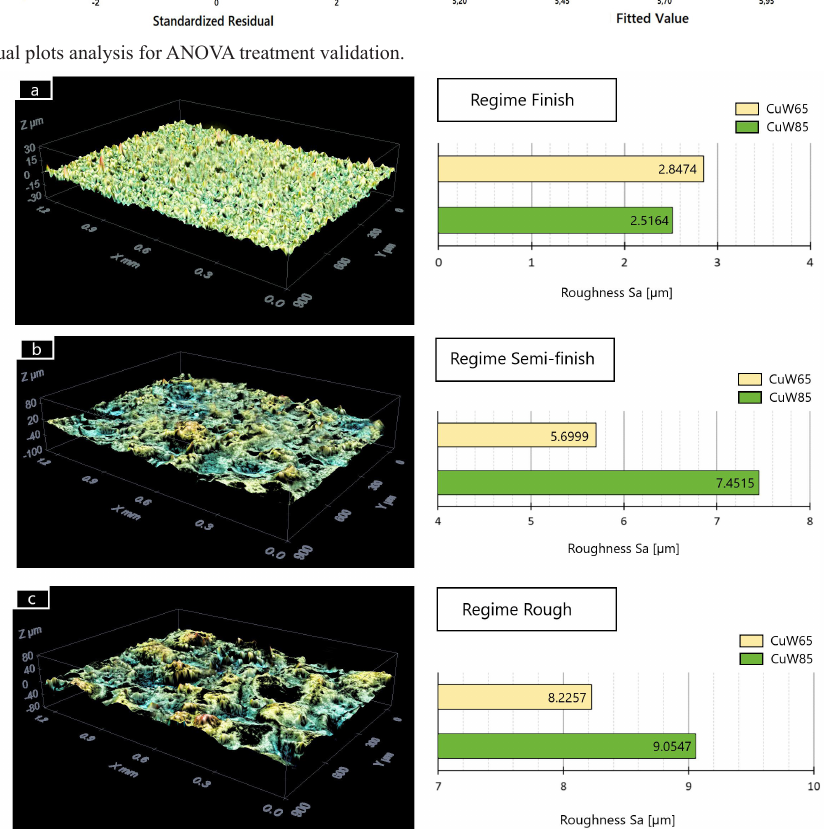
= 4 A, t = 13 µs), (b) semi-finish e e